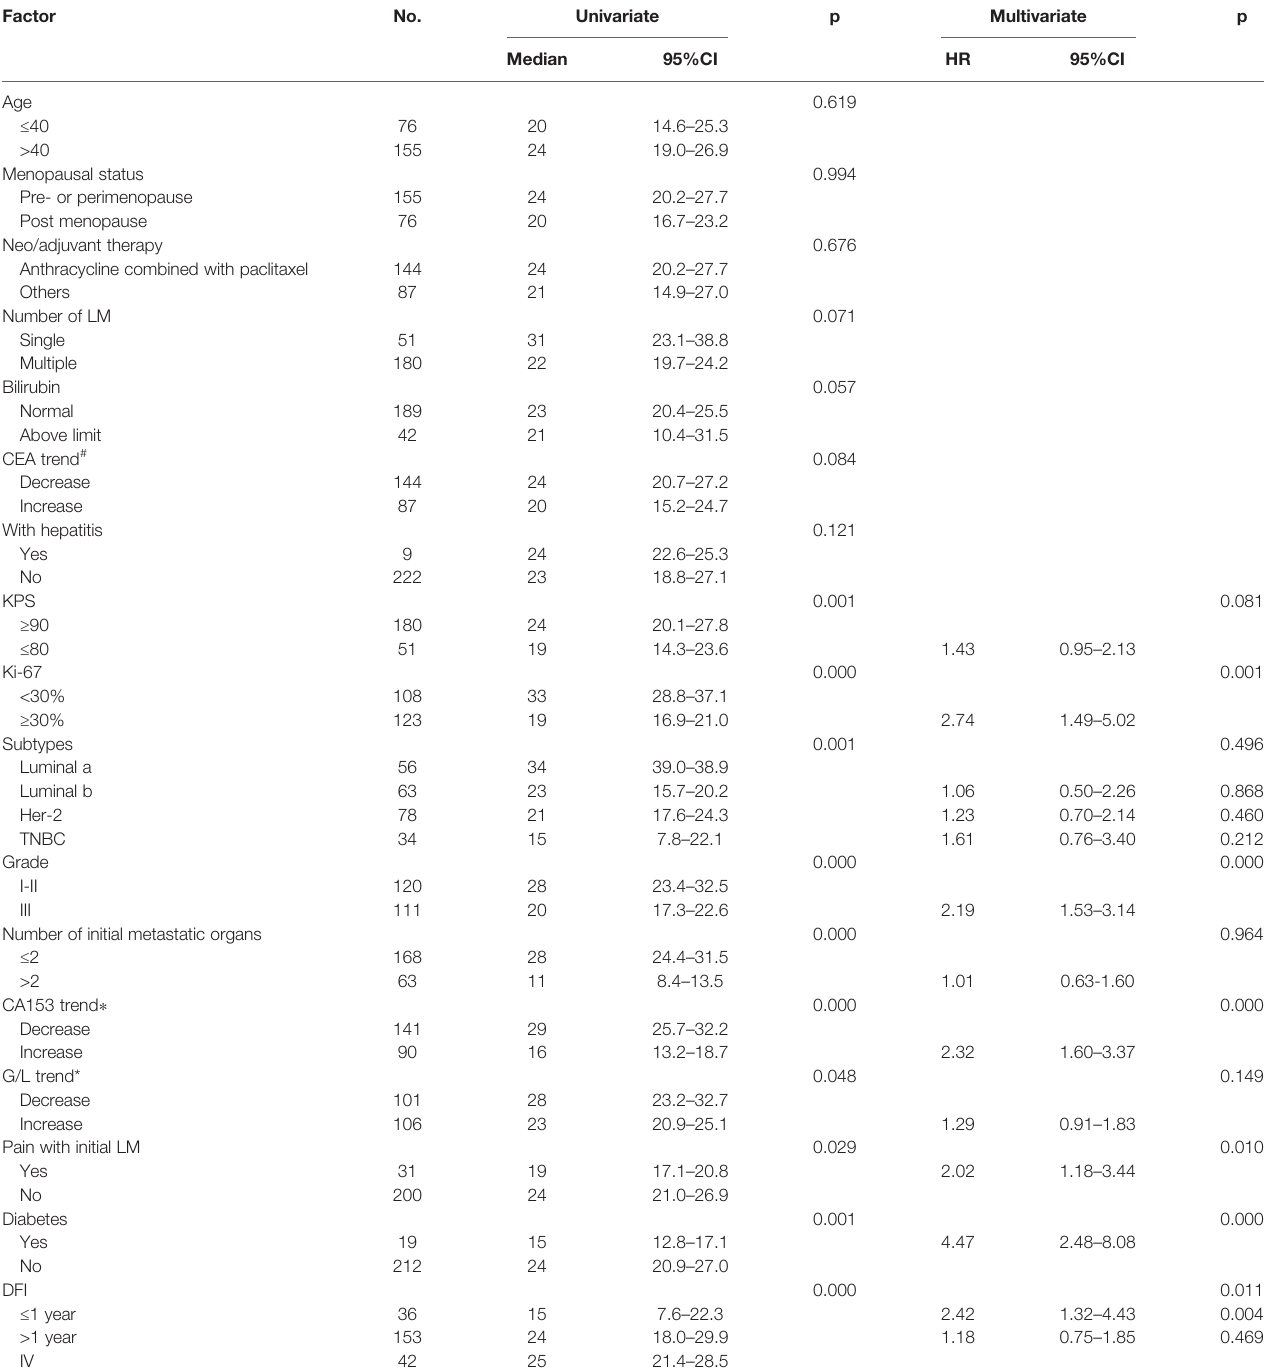
TABLE 3 | Univariate and multivariate models for OS with BCLM patients (n = 231). Factor No.